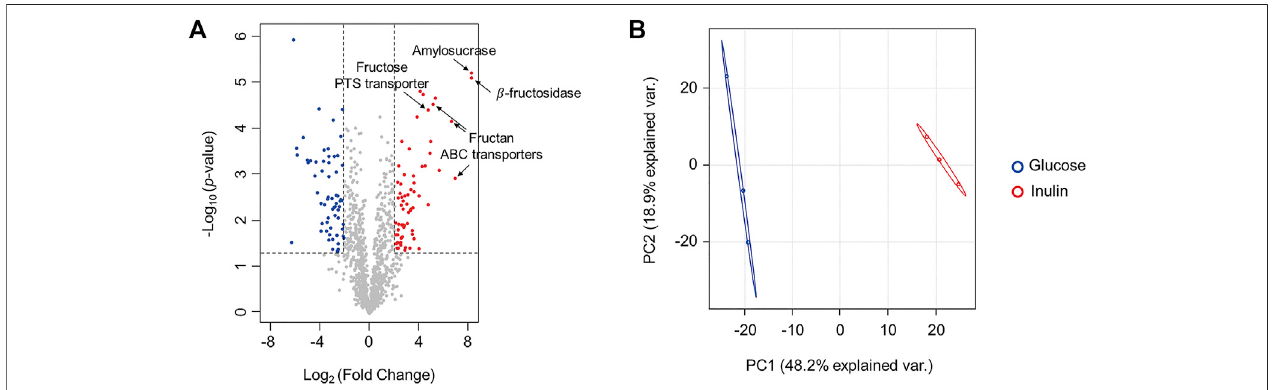
FIGURE3| Comparison ofproteomic changesof F.prausnitzii growninmYCFA supplementedwithglucoseorinulin. (A) Volcanoplotforproteomic changesof F. prausnitzii grown in mYCFA supplemented with glucose or inulin. Volcano plots indicate the upregulated proteins of inulin-grown F. prausnitzii in red circles and downregulatedproteinsinbluecircles.Indicationsareproteinsdiscussedinthisstudy. (B) Principalcomponentanalysis(PCA)plotofproteomicanalysisfor F.prausnitzii grown in each carbon source. Proteomic analysis was performed in